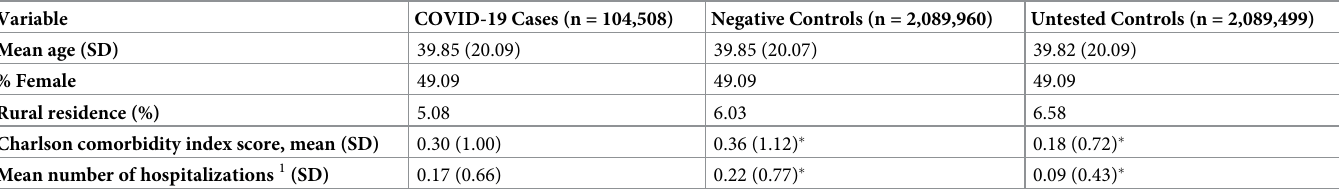
Table 1. Baseline characteristics of COVID-19 cases, negative controls, and untested controls.